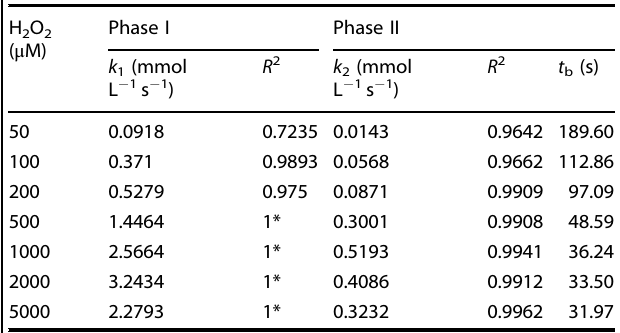
Table 1. Determination of the kinetic parameters of the proposed two-stage model of the degradation of CBZ with various [H 2 O 2 ]:[Fe 2 + ] ratios at [Fe 2 + ] = 50 μ